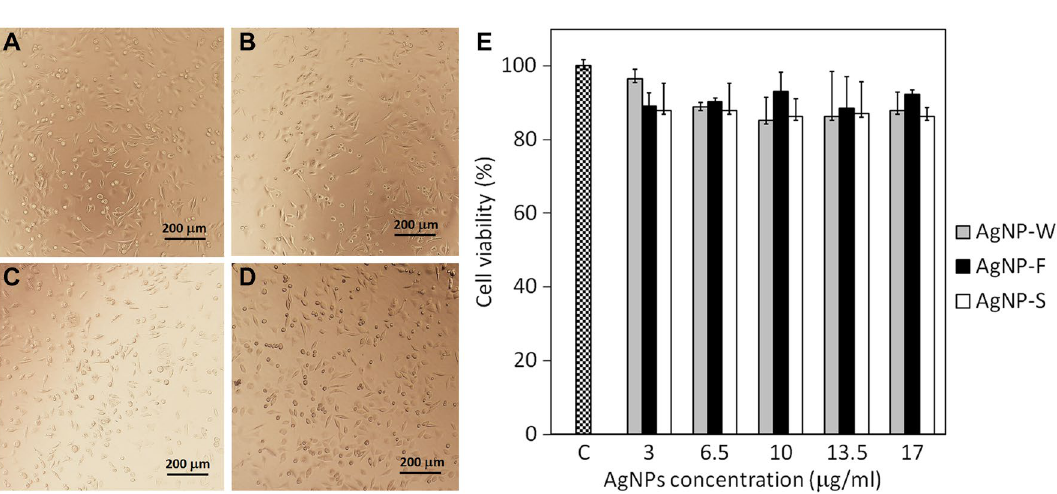
Figure 10. A microscopic pictures of HepG2 cells treated with AgNPs for 24 h in cell culture: control ( A ), AgNP-W ( B ), AgNP-F ( C ) and AgNP-S ( D ). After 24 h, the cell toxicity effect was examined with Crystal Violet ( E